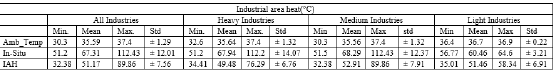
Table 5. Summary result for